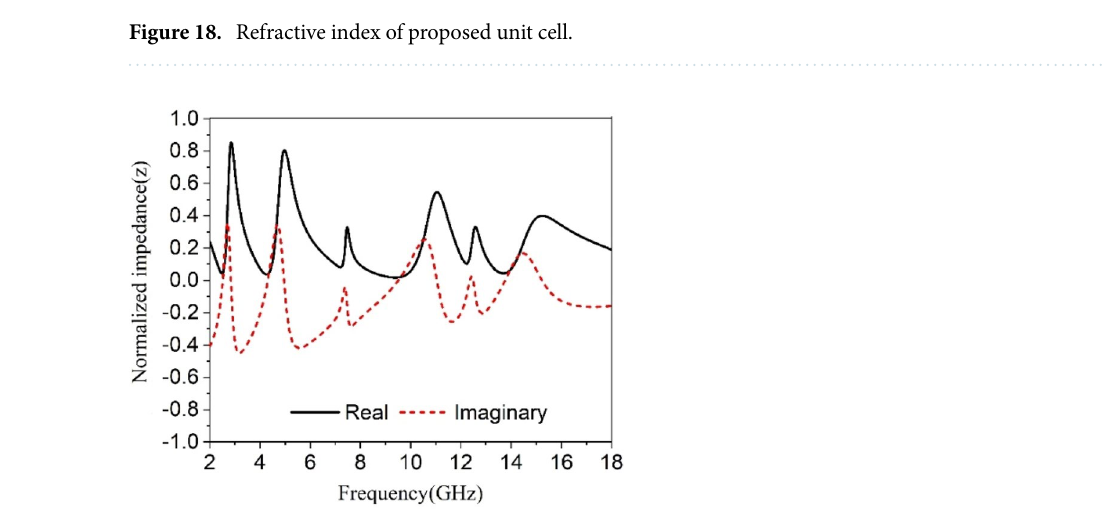
Figure 19. Normalized impedance of the proposed unit